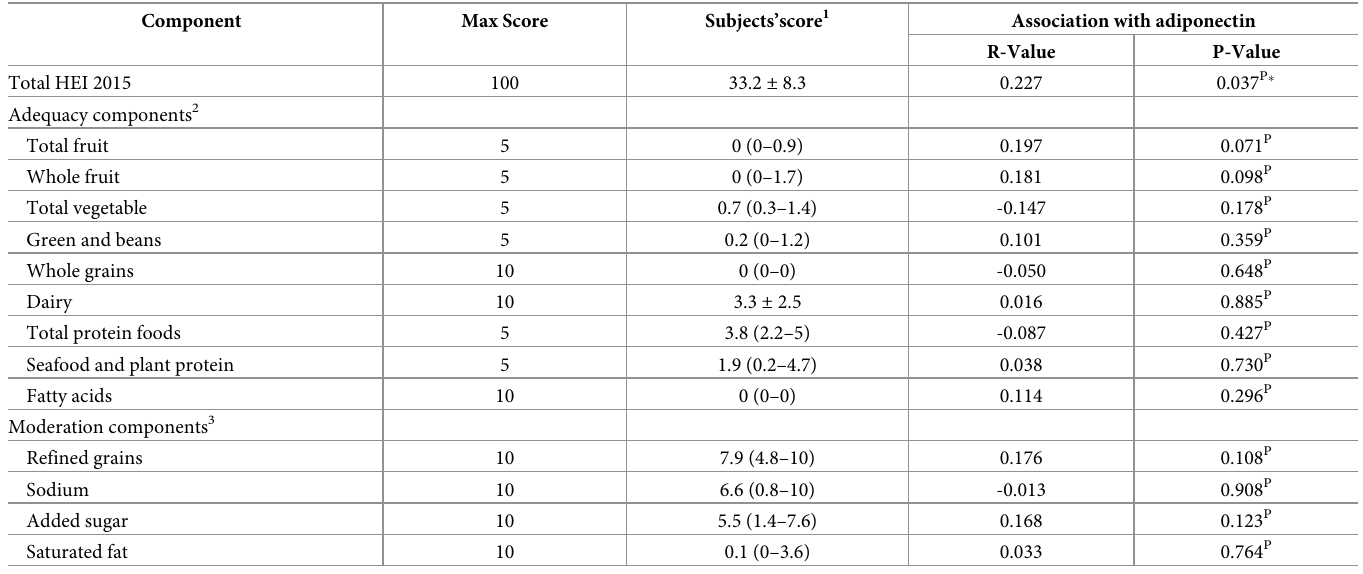
Table 2. Healthy Eating Index 2015 score and its association with serum adiponectin (n = 85).